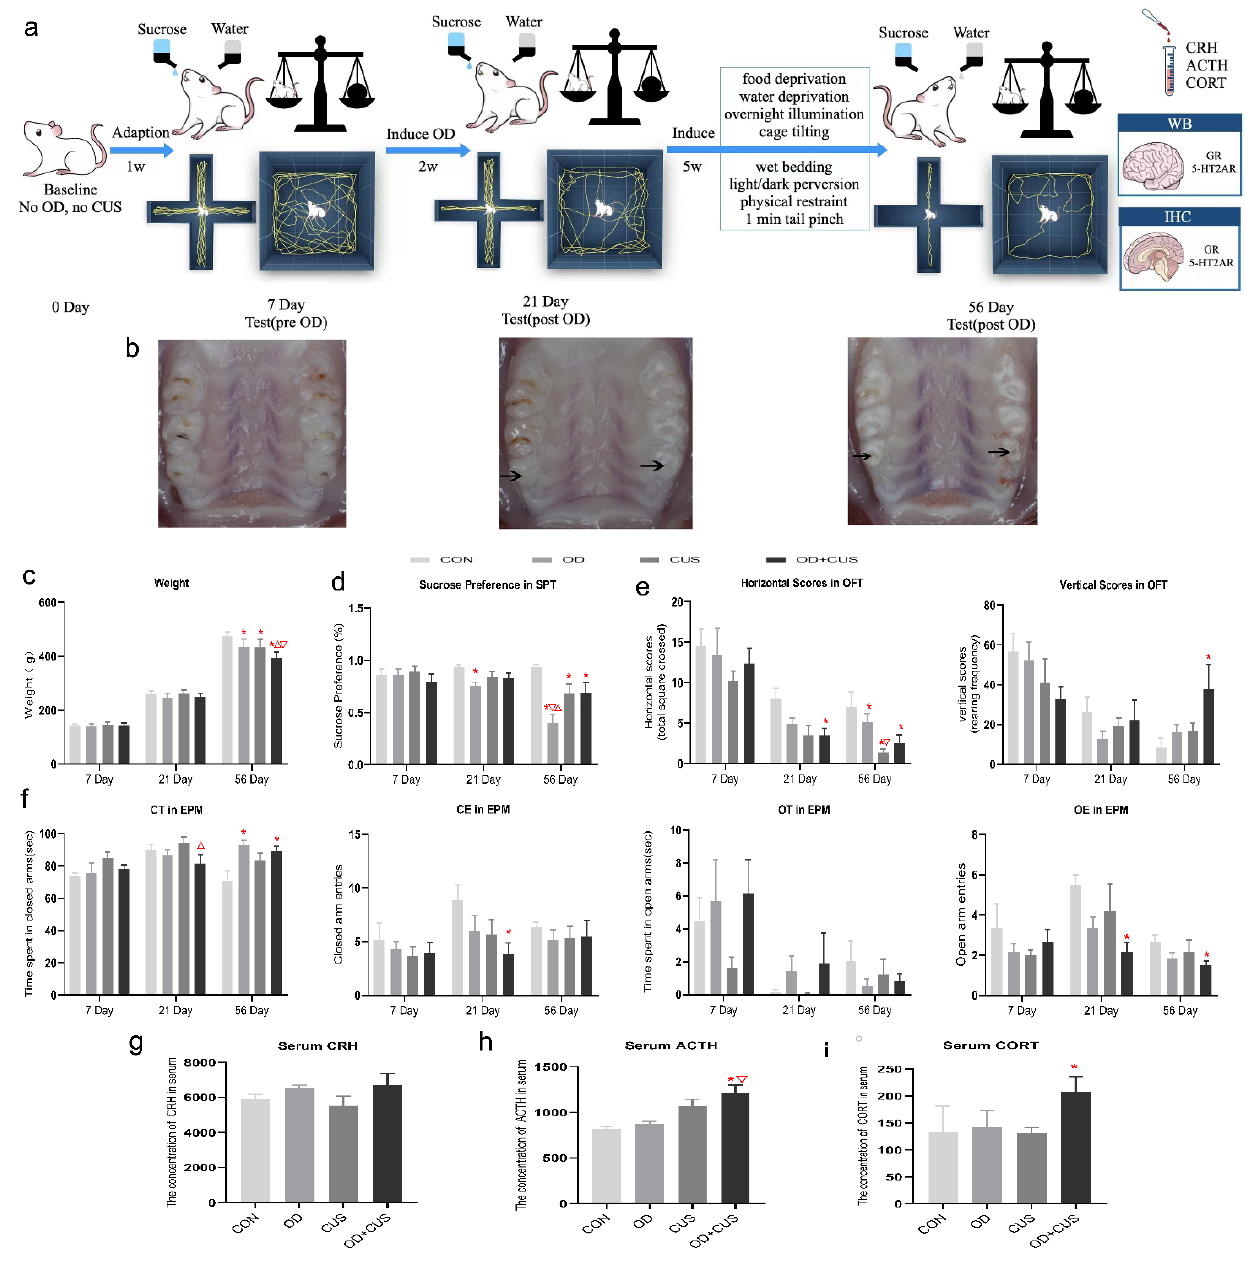
Figure 2 . Rats subjected to OD and CUS exhibit depressive-like behaviors. ( a ) Experimental design for the OD and CUS treatments. ( b ) Upper jaw specimens before OD on day 7, and after OD on days 21 and 56. Black arrows indicate the tooth abrasion produced by hand. ( c ) Body weight measure- ments. ( d ) Sucrose preference test results. ( e ) Open-field test, horizontal scores. ( f ) Time spent in the closed arms of the EPM, number of entries into closed arms of the EPM, time spent in open arms of the EPM, number of entries into open arms of the EPM. ( g ) Serum CRH levels. ( h ) Serum ACTH levels. ( i ) Serum CORT levels. Values represent the mean ± SEM. * p < 0.05, compared with the CON group. ▽ p < 0.05, compared with the OD group. △ p < 0.05, compared with the CUS group.